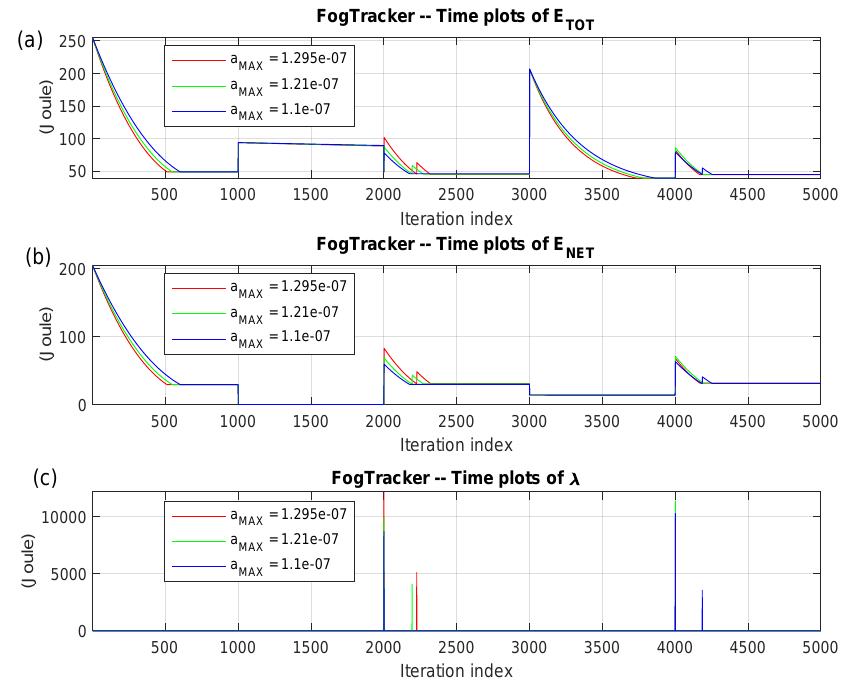
Figure 7. Tracking performance under DAG1 for three values of the speed-factor a MAX . ( a ) time behaviors of the total energy E TOT ; ( b ) time behaviors of the corresponding network energy E NET ; and ( c ) time behaviors of the λ